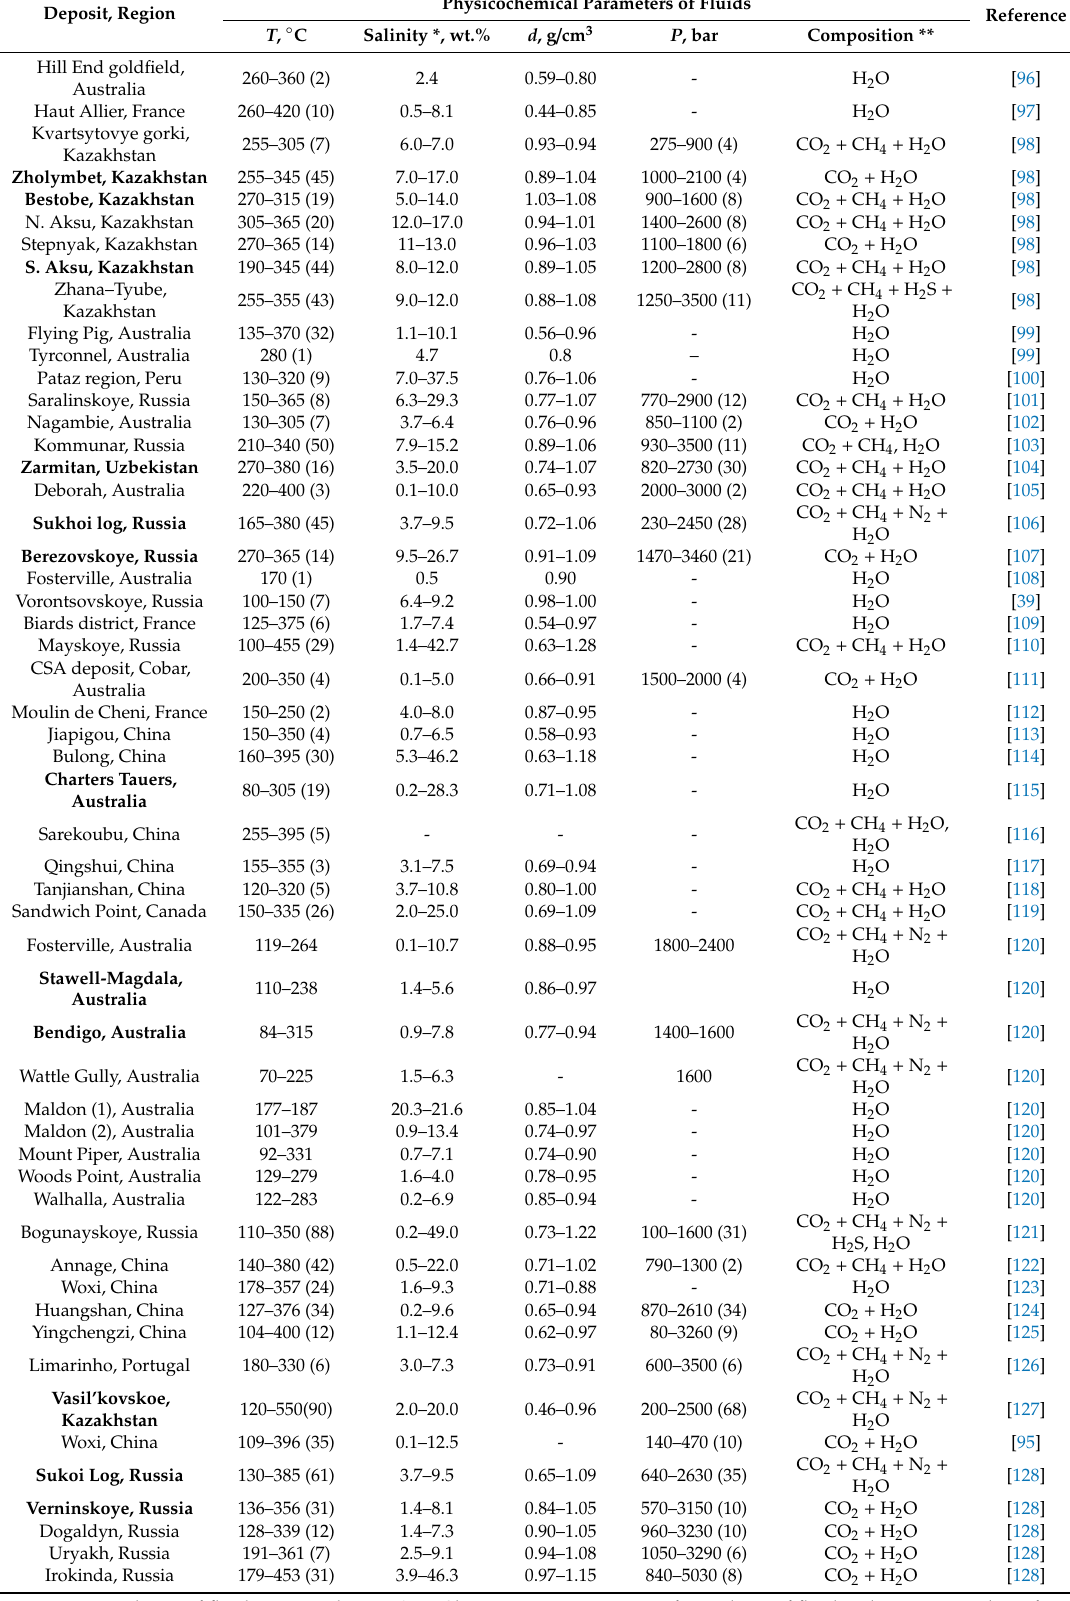
Table 4. Parameters of mineralizing fluids of Paleozoic gold